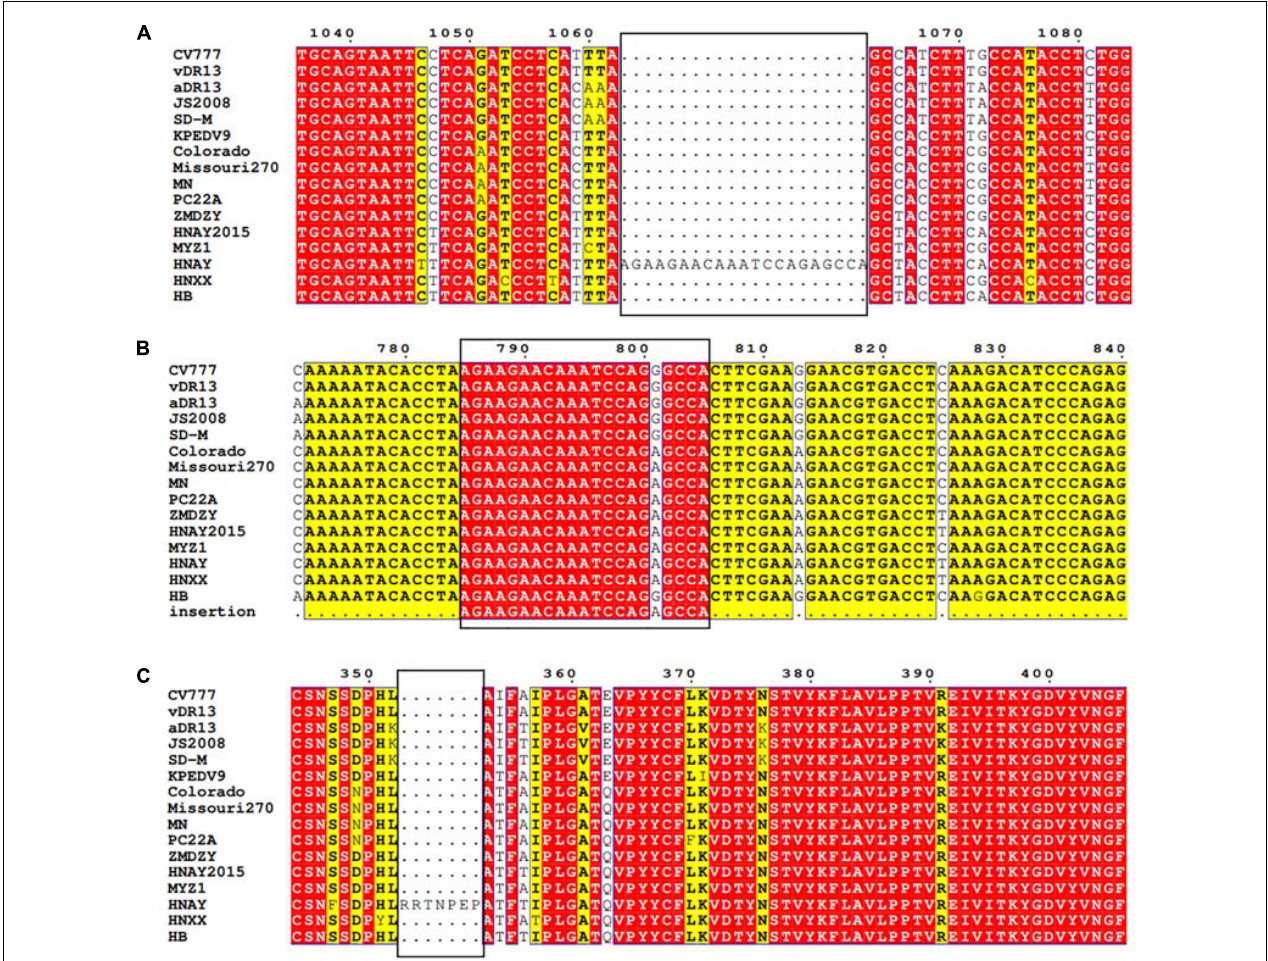
FIGURE 2 | Sequence analysis of S gene of PEDV HNAY with representative PEDV strains. (A) Nucleotide alignment of partial S gene of PEDV HNAY with different types of reference strains. The novel insertion (AGAAGAACAAATCCAGAGCCA) in HNAY S gene is depicted as a black box. (B) Nucleotide alignment of partial N gene of PEDV HNAY with different types of reference strains. The black box indicates the position of 21 nucleotides inserted into the S gene in N gene. (C) Amino acid alignments of the partial S1 protein, insertions of seven amino acids are depicted as black boxes.